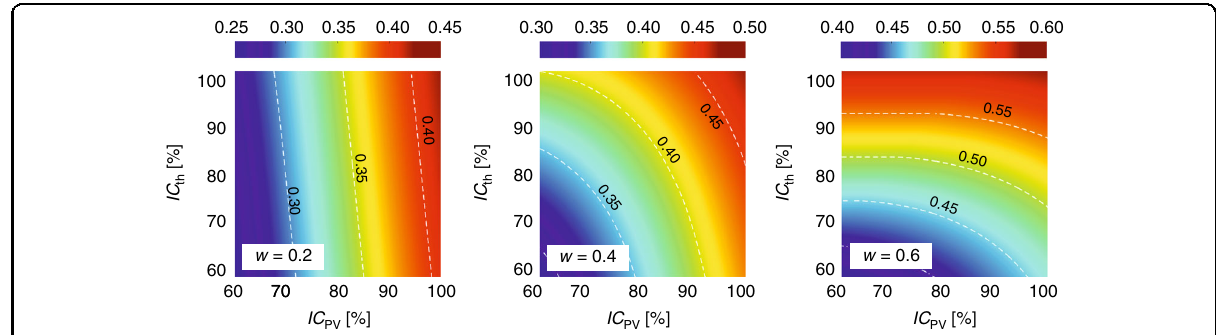
Fig. 11 In fl uence of non-ideal coef fi cients of the PV cells and thermal absorber, IC PV and IC th , on the SSPVT total effective ef fi ciency limit η tot ( C = 100, PV material: